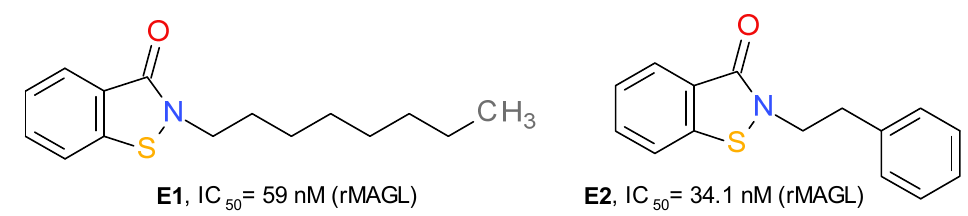
Figure 7. Irreversible MAGL inhibitors—benzisothiazolinone derivatives.